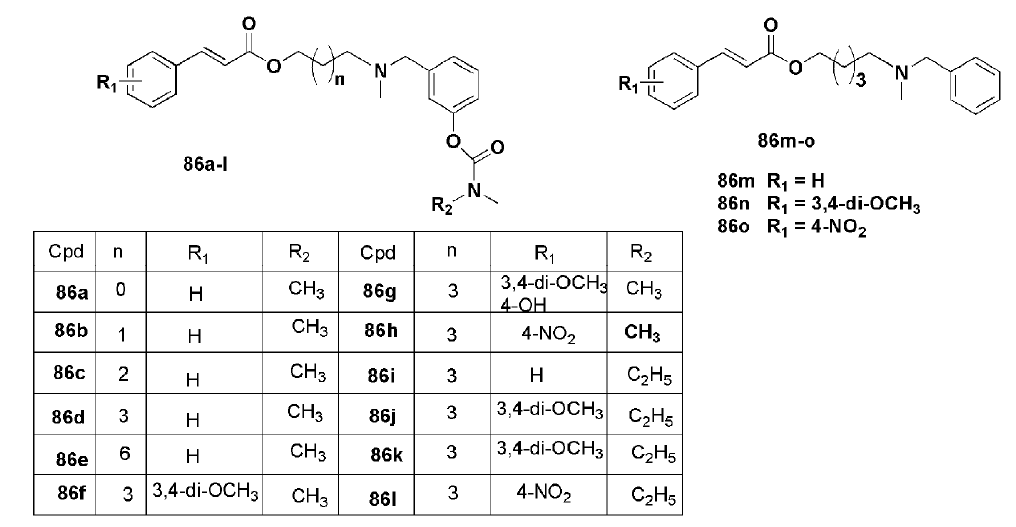
Figure 22. Chemical structures of compounds 86a–o [60].